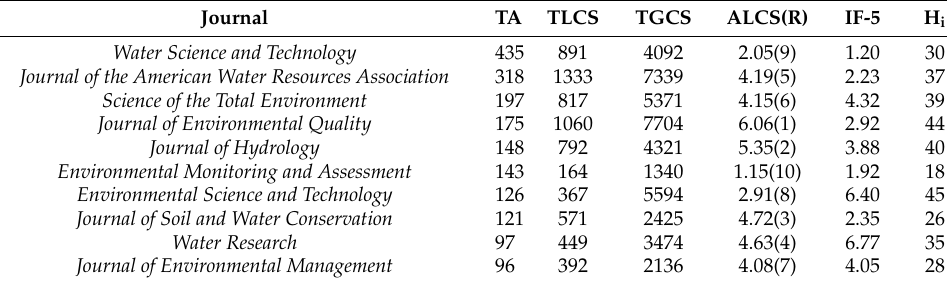
Table 2. Top 10 most productive journals